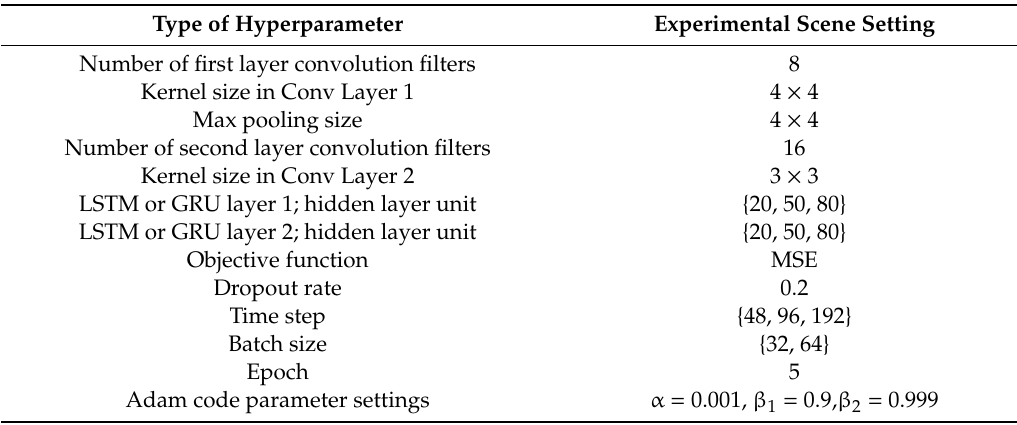
Table 4. Hyperparameters of deep learning